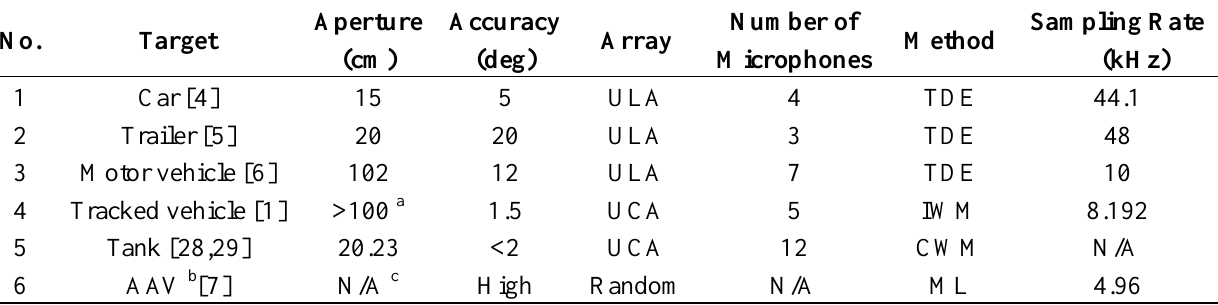
Table 4. Performance comparison with other systems.